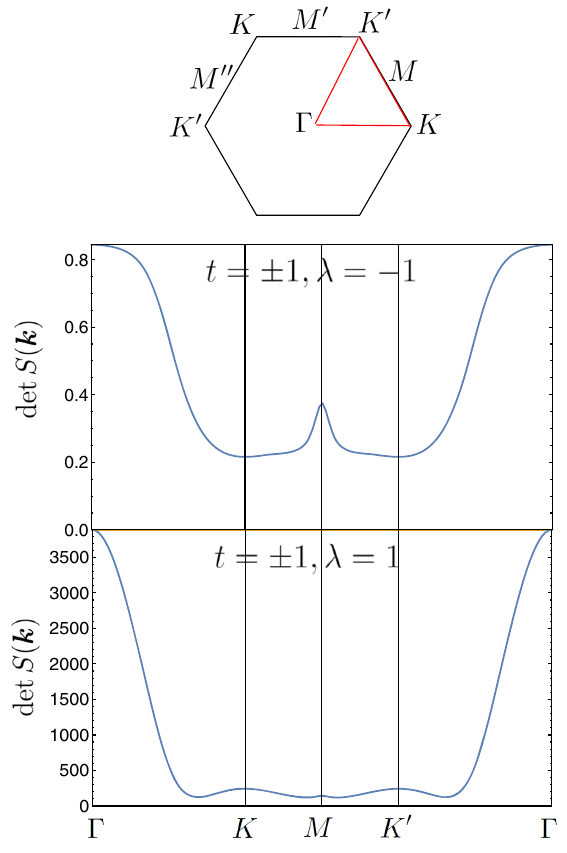
FIG. 12. The determinant of the overlap matrix S ð k Þ for the basis choices given in Eqs. (75), (78) – (80) (note that the curves for t ¼ (cid:1) 1 are